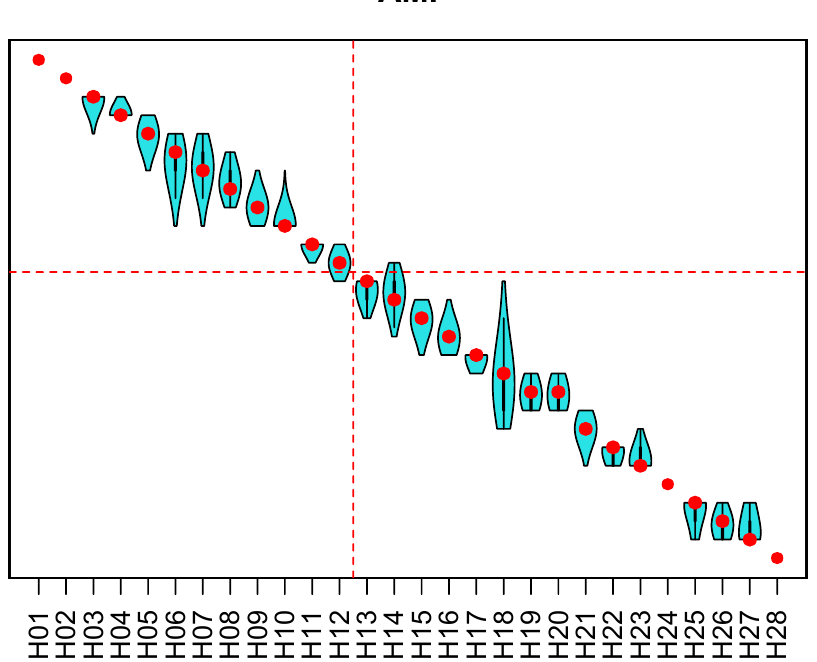
Figure 6. Results of the sensitivity analysis for the ranking of hospitals with respect to the acute myocardial infarction. Violin plots show distribution of ranks from the Monte Carlo simulation. Dashed red lines indicate the 40% best-performing